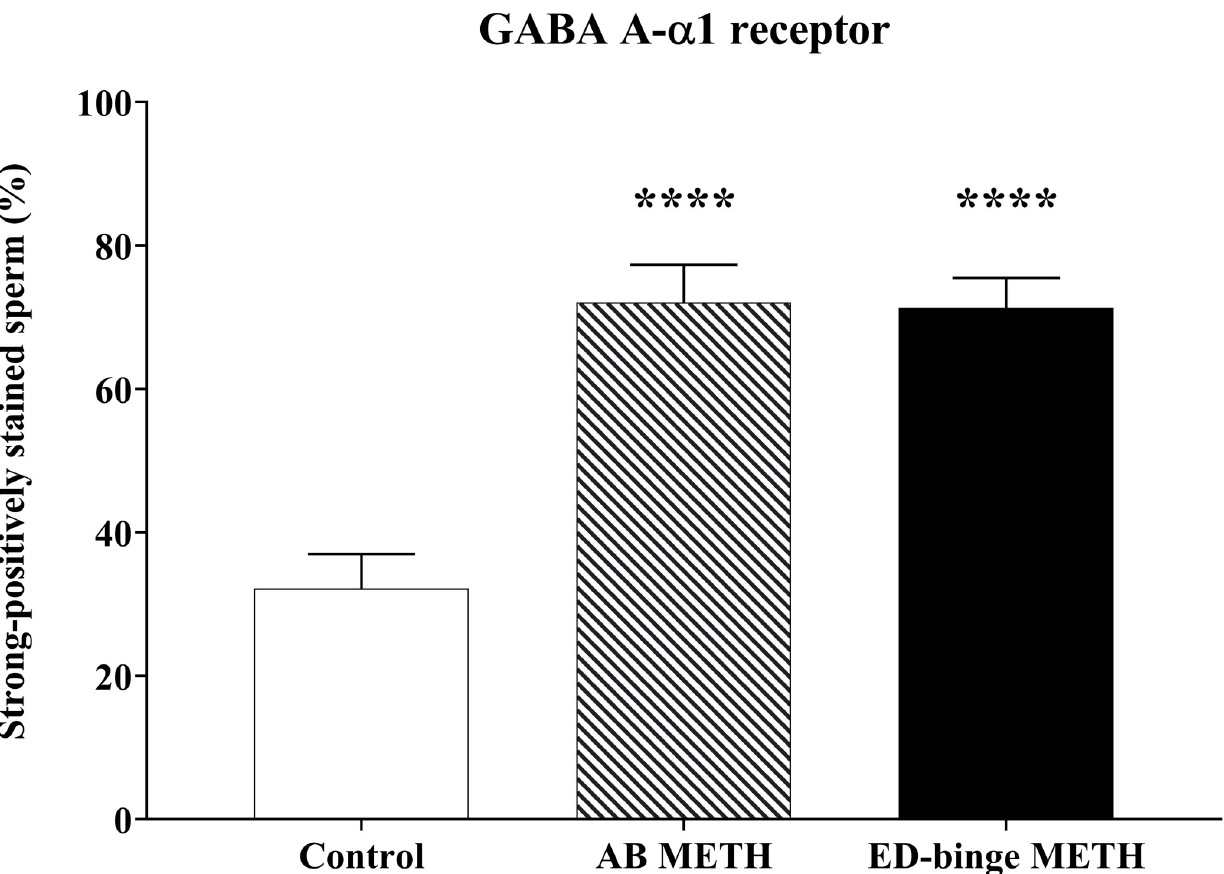
Fig 5. Percentage of strong-positively stained sperm for GABA A- α 1 receptor immunostaining (METH vs. control). Values are shown as mean ± SEM, n = 8–9 per group ( ���� P < 0.0001; Dunnett’s post hoc test).